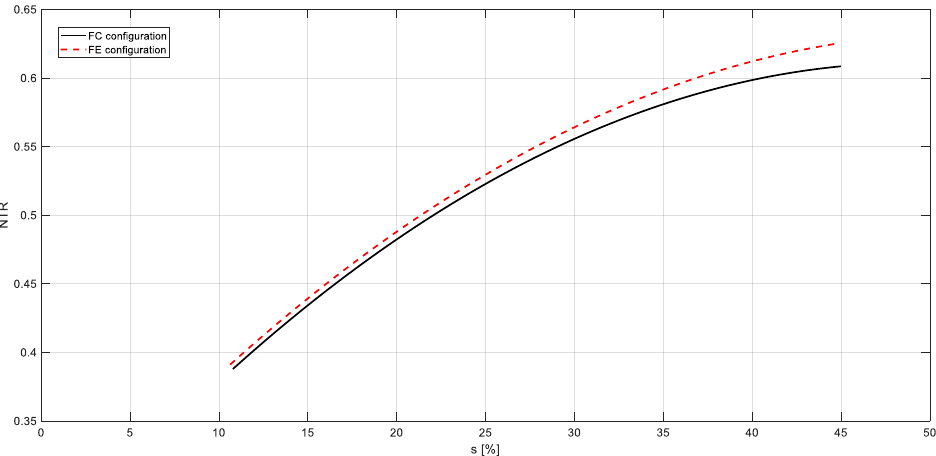
Figure A5. NTR-s regression curves (E2)) obtained from the field tests performed in 8th gear in FC and FE configuration. Table A3. Regression parameters for the NTR-s relationship in 8th gear. Regression